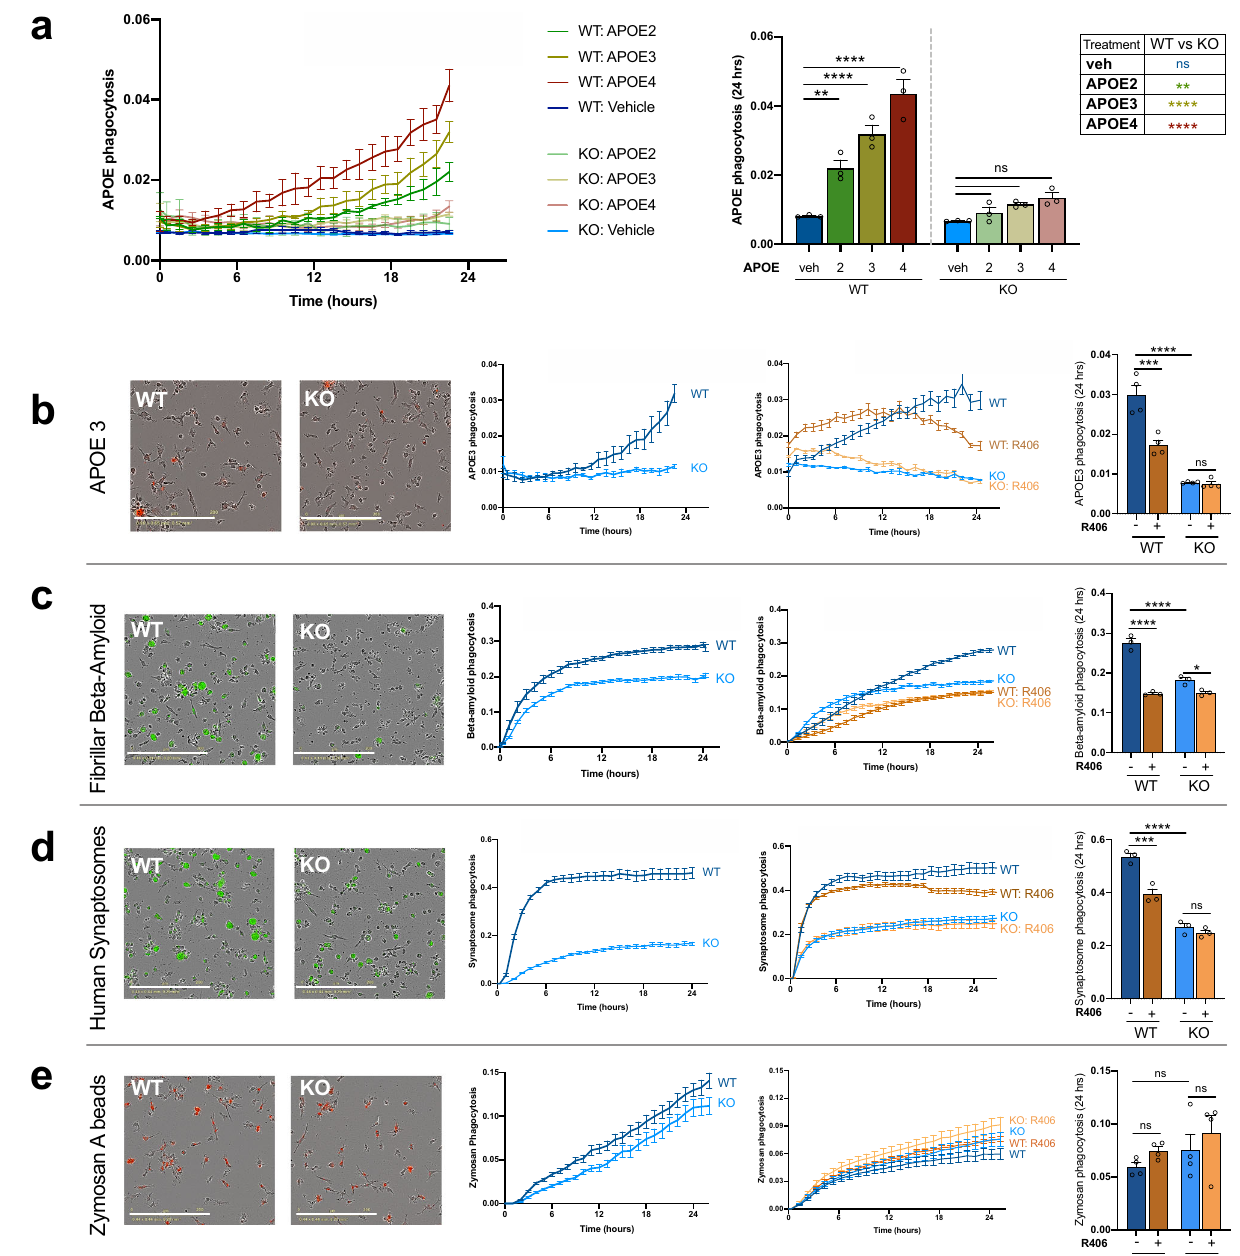
Fig. 3 TREM2 knockout decreases phagocytosis of disease-relevant stimuli. a Isogenic TREM2 WT and KO microglia were exposed to recombinant APOE 2 (green), APOE 3 (yellow), APOE4 (red), or a vehicle control (blue). Images were taken every hour for 24 h with IncuCyte S3 live imaging system. Scale bar: 200 μ m. Statistical differences were quanti fi ed at 24 h (right, n = 3 independent wells with 4 images per well. Table (right) shows difference between WT and KO lines for each APOE genotype replicated in 2 isogenic backgrounds; two-way ANOVA, Tukey post hoc test, multiple comparisons. WT(veh) vs WT(APOE2): p = 0.0052, WT (APOE2) vs KO (APOE2): p = 0.0075, **** p < 0.0001, ns: p > 0.8.) Data are represented as mean values ± SEM. Microglia were exposed to b recombinant APOE3 (red), c fi brillar fl uorescent beta-amyloid (green), d pHrodo-labeled human synaptosomes (green), or e pHrodo-labeled Zymosan A (red). Left shows representative images at 24 h. Inner graphs show untreated cells and the relative effects of TREM2 deletion alone on phagocytosis, or with addition of a SYK inhibitor (5 μ M R406). Statistical differences were quanti fi ed at 24 h (right). For all panels, n = 3 – 4 independent wells with 4 images per well; two-way ANOVA, Tukey post hoc test, multiple comparisons. b *** p = 0.0002, **** p < 0.0001, ns p = 0.998 c * p = 0.0393, **** p < 0.0001 d *** p = 0.0008, **** p < 0.0001, ns p = 0.7912 e WT vs WT + R406 p = 0.301, KO vs KO + R406 p = 0.320, WT vs KO p = 0.344. Data are represented as mean values ± SEM. Experiments were replicated in three isogenic lines with equivalent